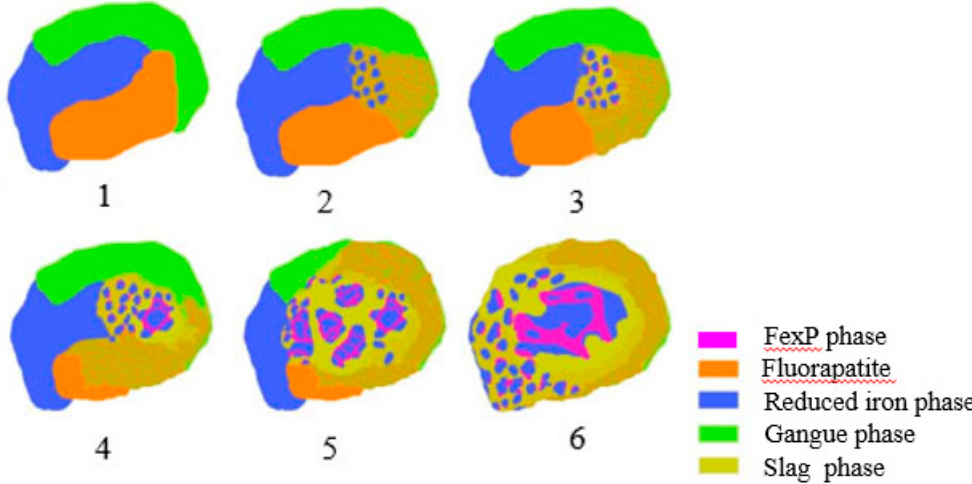
Figure 15. The schematic illustration of the reduction route of high-phosphorus iron ore.